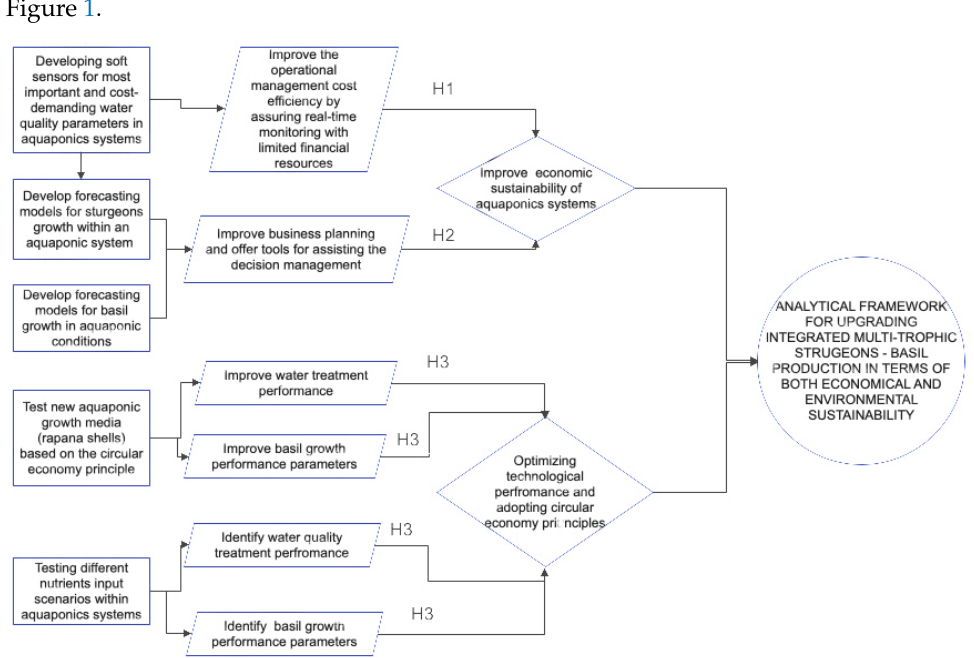
Figure 1. Research hypothesis